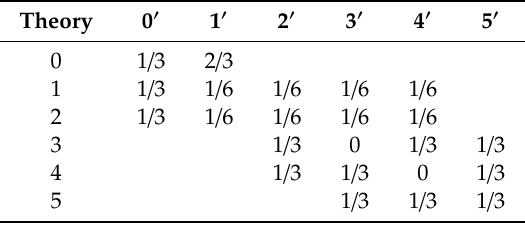
Table 1. Theoretical prediction of the ratio of output power for each output port y (cid:48) (0 (cid:48) –5 (cid:48) ) when laser is injected into each input port x (0–5).